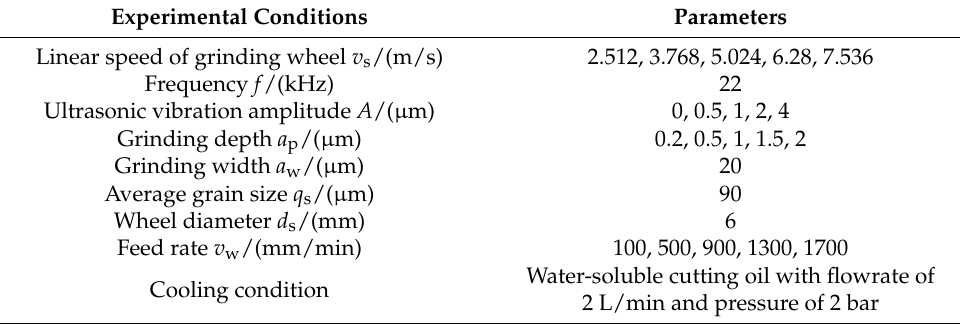
Table 2. The process parameters of grinding.